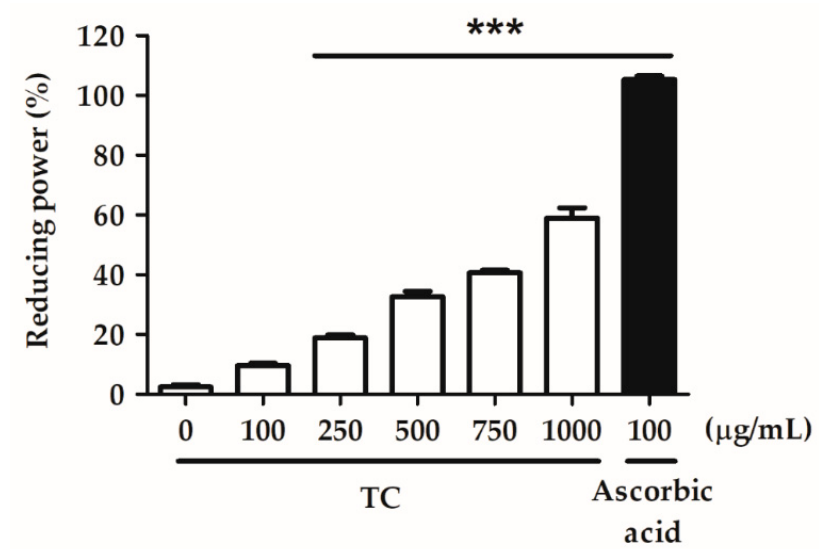
Figure 3. TC displays a concentration-dependent reducing power. TC exhibited a dose-dependent reducing power with an EC 50 value of 857.9 µ g/mL. Ascorbic acid was used as a positive control. Sig- nificant differences between the treated groups and the negative control were evaluated. *** p < 0.001 compared to the control group.